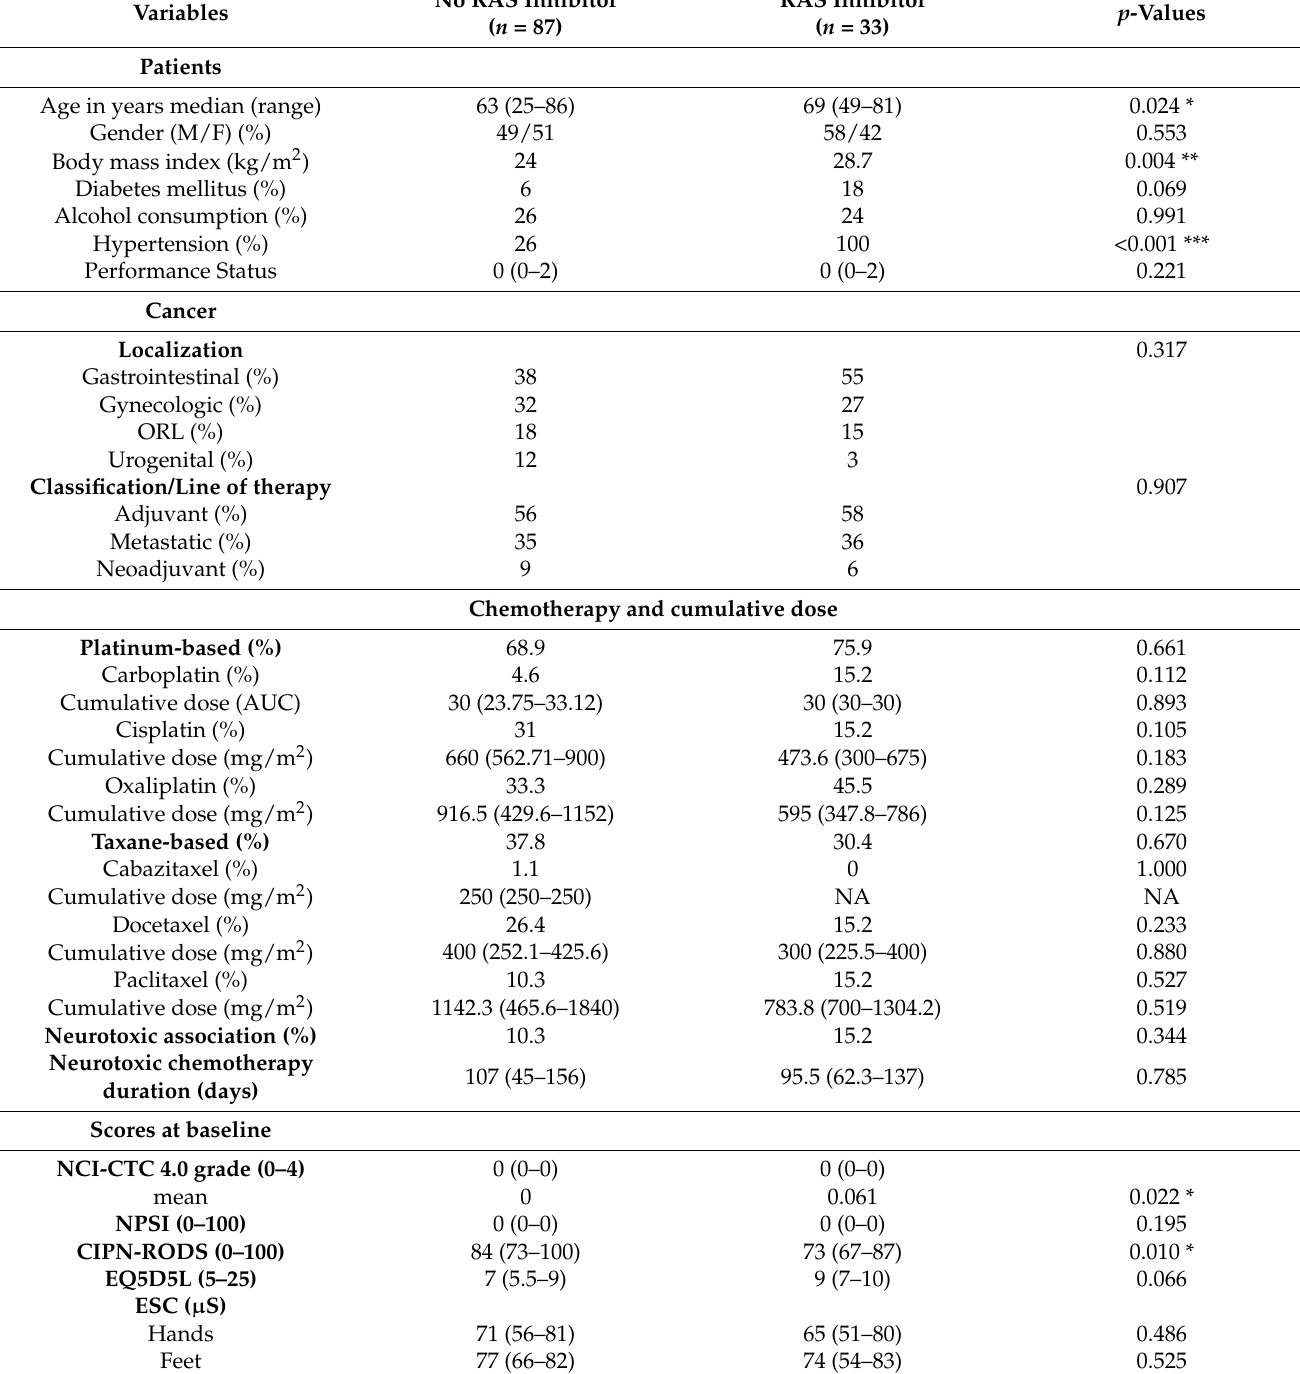
Table 1. Characteristics of patients at study entry, expressed as median and interquartile